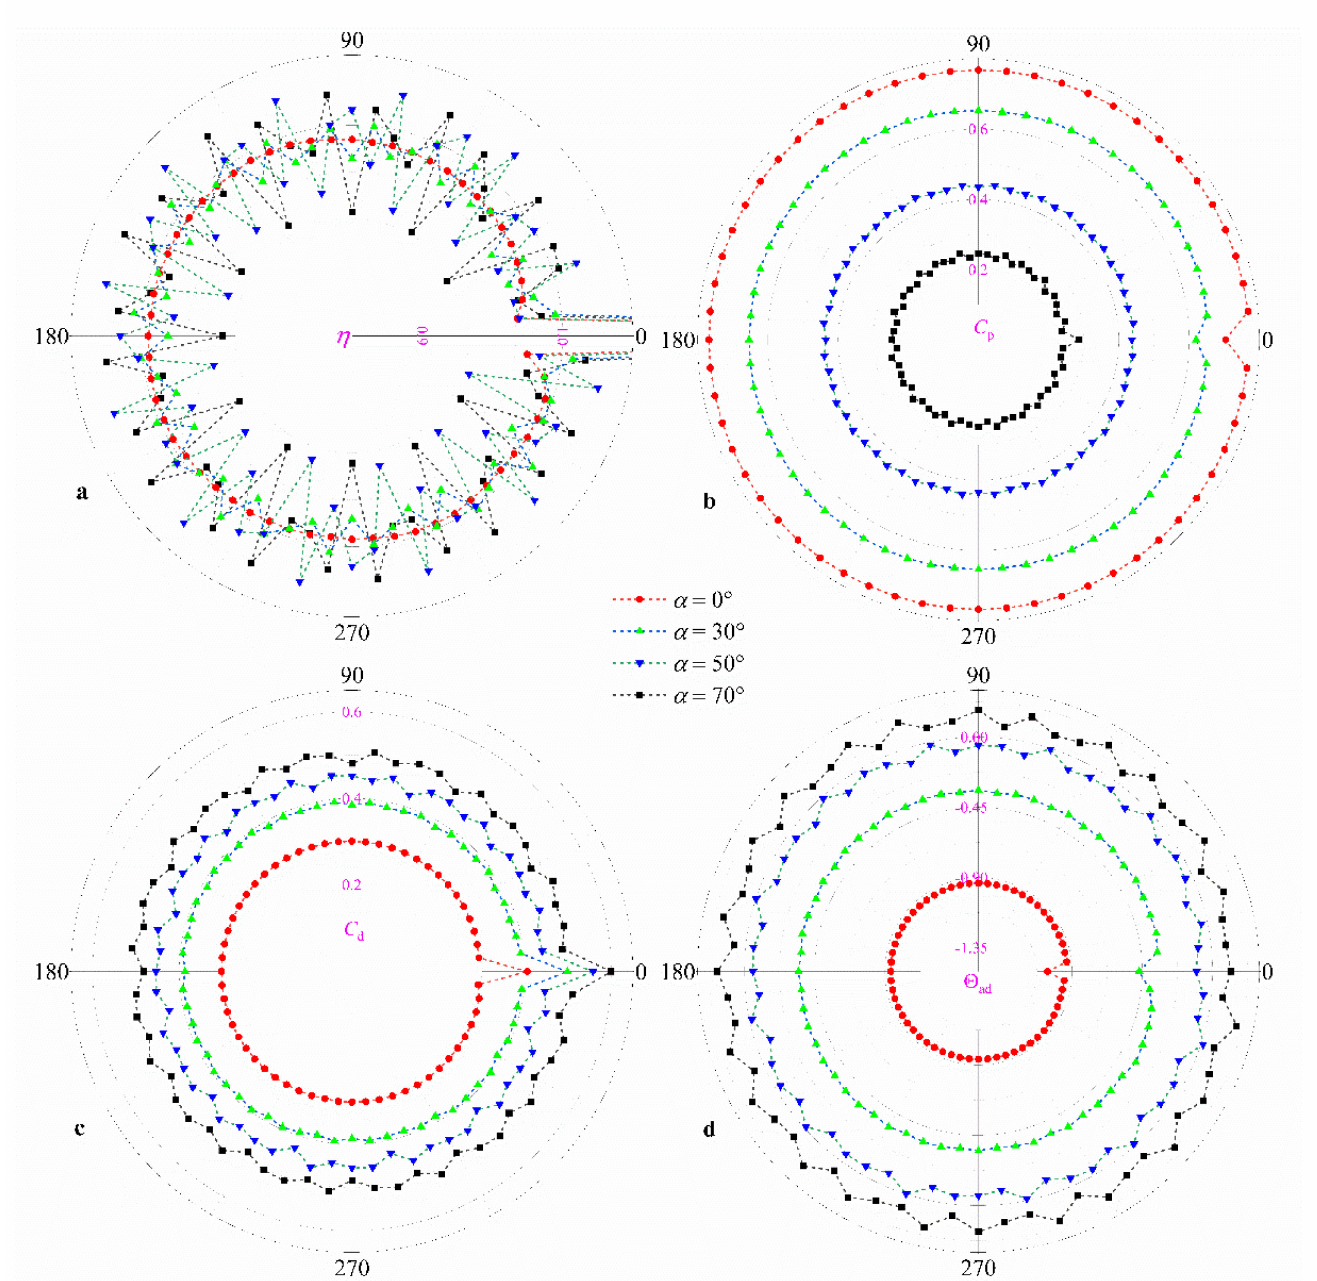
Figure 8. Distribution of ( a ) mass-flow-rate ratio η , ( b ) total-pressure-loss coefficient C p , ( c ) discharge coefficient of holes C d , and ( d ) adiabatic effectiveness Θ ad for different pre-swirl angles α